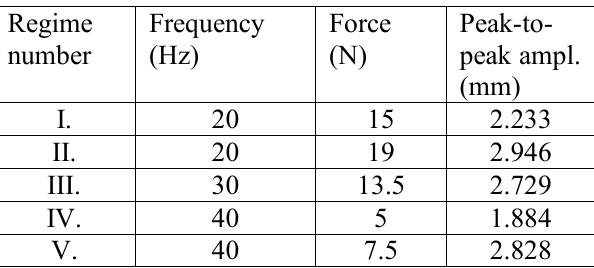
Fig. 1. Blade cascade, plane of symmetry. Table 1. Tested regimes.